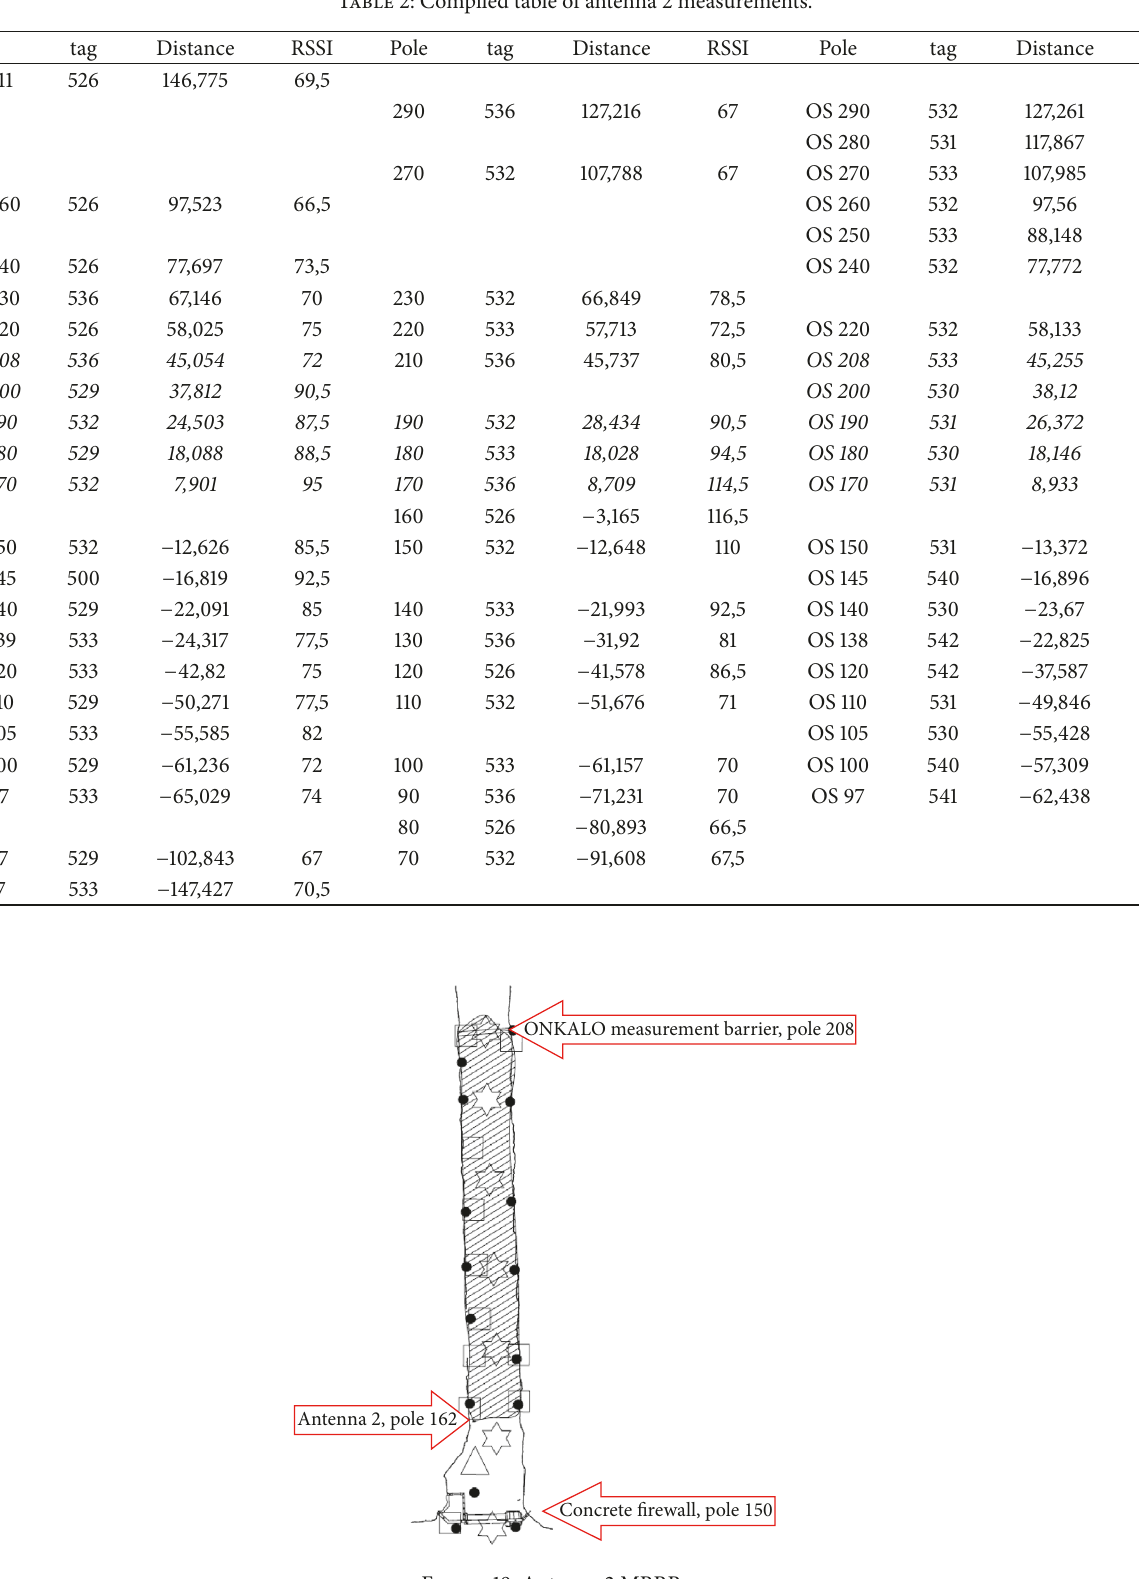
Table 2: Compiled table of antenna 2 measurements.